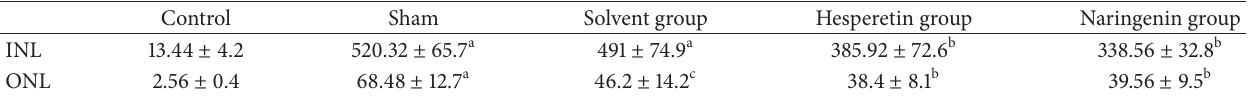
Table 3: Number of caspase-3 positive cells in the